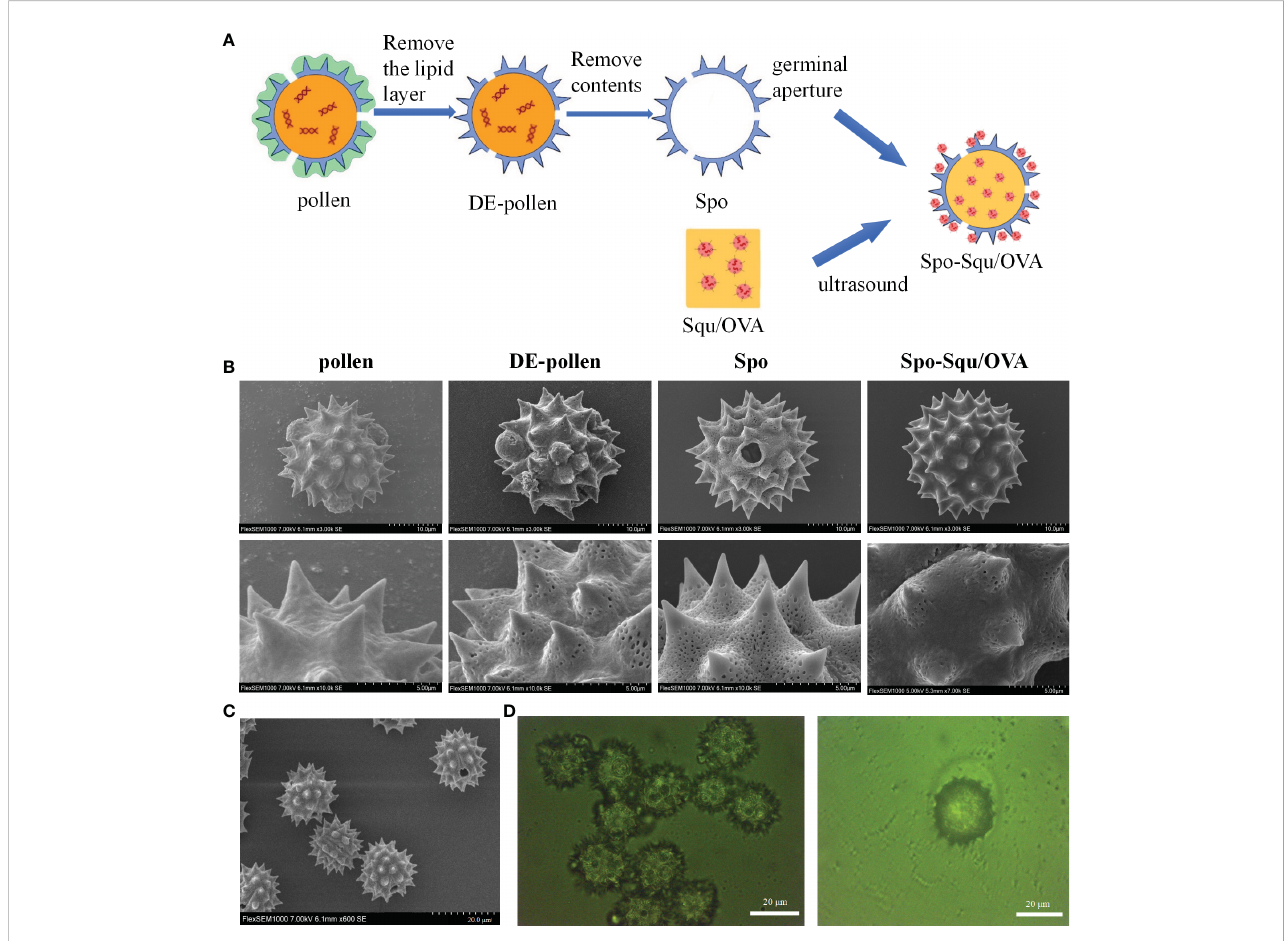
FIGURE 1 Preparation process of Spo-Squ/OVA and the shape and morphology of sporopoll en in carrie. (A) Schematic diagram of Spo-Squ/OVA preparation process fl ow chart. (B) SEM images of pollen, DE-pollen, Spo and Spo-Squ/OVA samples at different magni fi cations. (C) Morphology of Spo under SEM. (D) Morphologies under Spo-Squ/OVA fl uorescence microscope. Scale bars: (B) 10 m m, 5 µm, (C) 20 m m, (D) 20